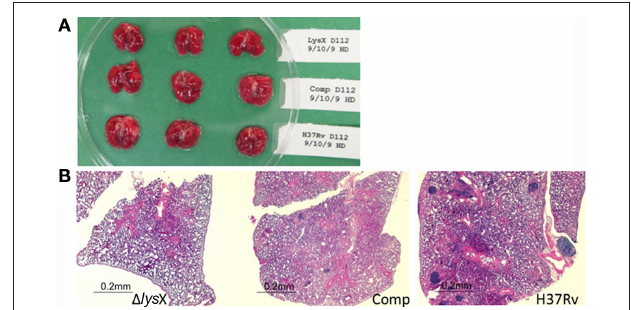
FiguRe 5 | Mouse lung gross pathology and histopathology at day 112 after infection. (A) Gross pathology of the lungs infected with the M. tuberculosis lys X mutant (top row), lys X tet complement (middle), and wild-type (bottom) strains. (B) Lungs from mice were excised, stored in 10% formalin, embedded, and stained with hematoxylin and eosin for histopathological analysis. Hematoxylin-eosin staining confirmed that the